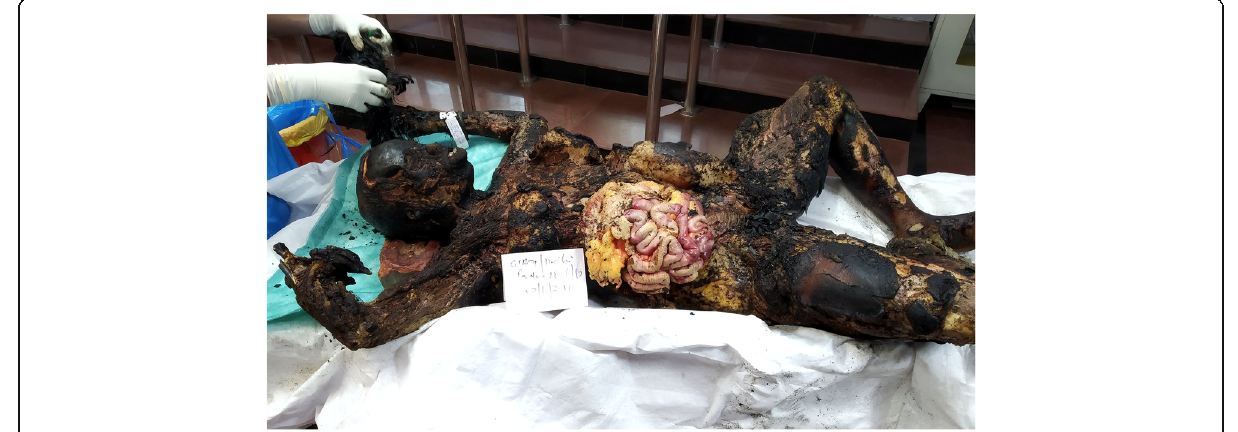
Fig. 3 Intestinal loops protruding out of the abdominal cavity (case